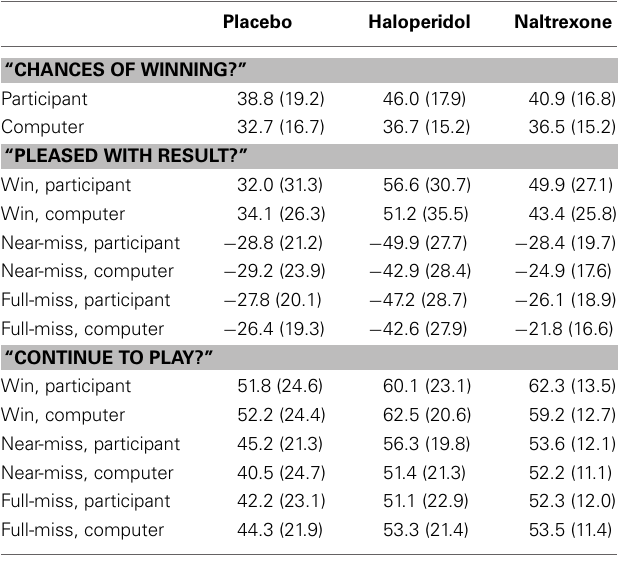
Table 2 | Subjective ratings on the slot machine task.